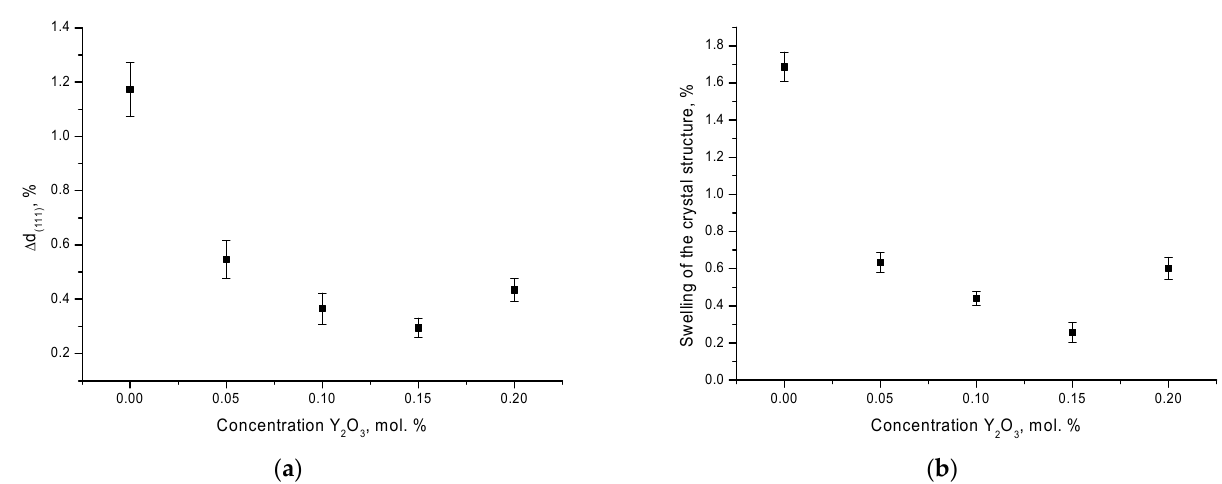
Figure 8. ( a ) Results of deformation strain of the crystal structure as a result of irradiation; ( b ) results of swelling of the crystal structure as a result of irradiation.